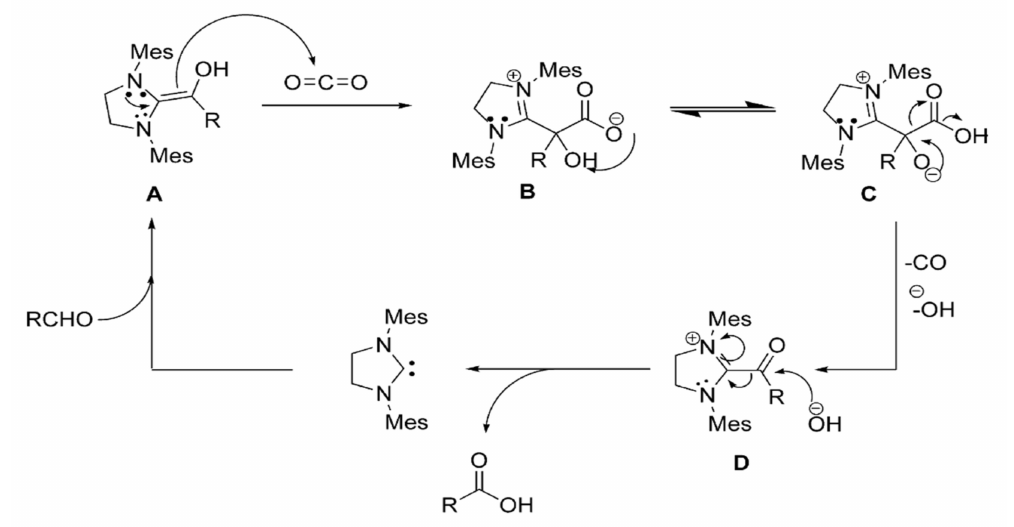
Scheme 4. Proposed Mechanism for aldehyde assisted CO 2 to carboxylic acid process. (Reprinted from [34]; copyright (2010), American Chemical